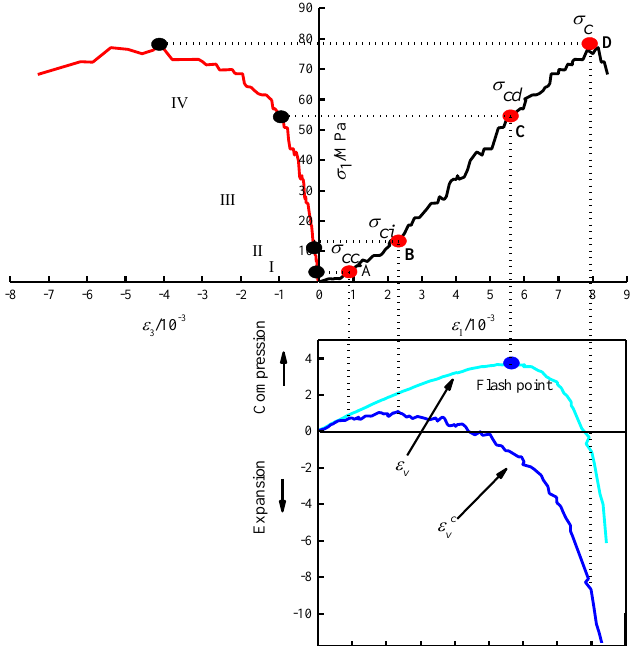
Figure 2. Identification of stress–strain curves of intact sandstone specimens and their characteristic strengths.